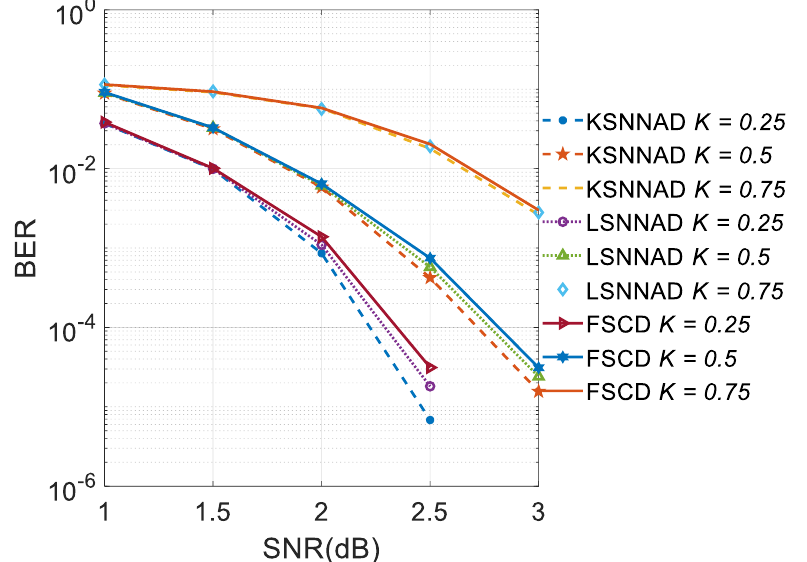
Figure 14. Decoding results of different code rates.